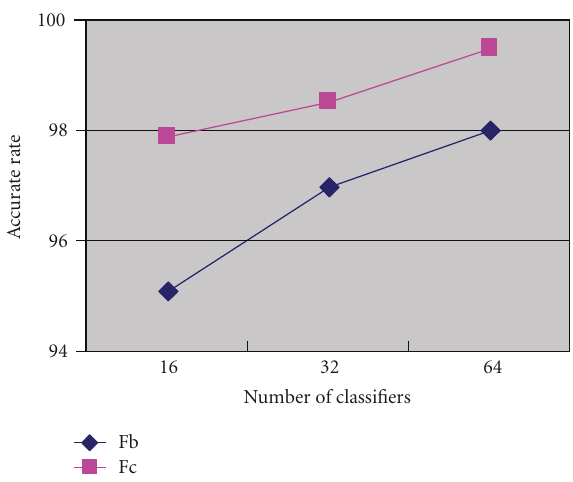
Figure 4: Performance of Atan K-HLGPP for di ff erent number of classifiers on FERET Fb and Fc.